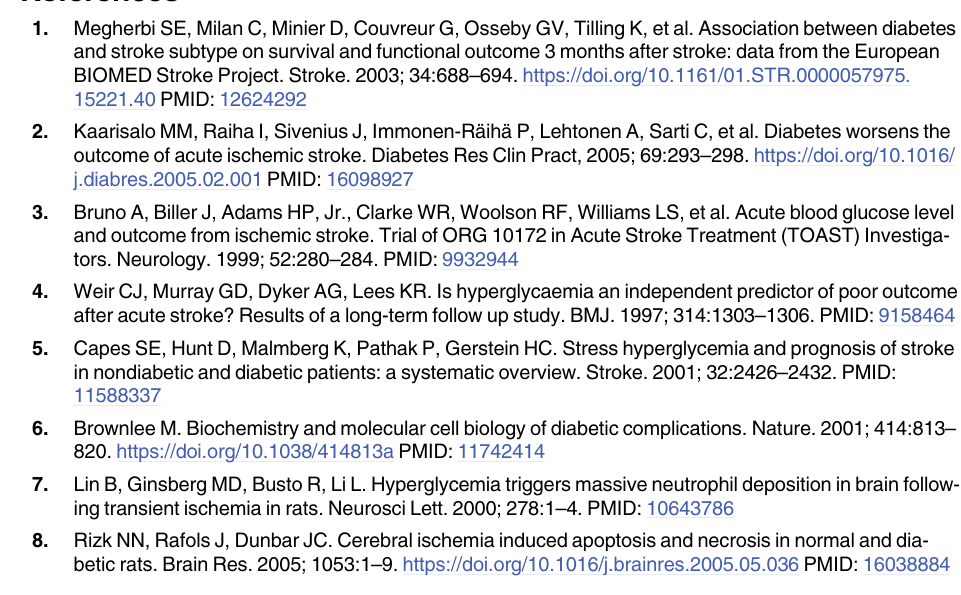
S1 Table. Multivariable ordinal logistic regression analyses of the predictors of unfavor- able shift in modified Rankin Scale score distribution at 3 month. OR, odds ratio; CI, confi- dence interval; TIA, transient ischemic attack; TOAST, Trial of Org 10172 in Acute Stroke Treatment; LAA, Large Artery Atherosclerosis; SVO, Small Vessel Occlusion; CE, Cardioem- bolism; SOE, Stroke of Other determined Etiology; SUE, Stroke of Undetermined Etiology; NIHSS, National Institutes of Health Stroke Scale; IV, Intravenous; A1c, glycated hemoglobin; Q1–4, quartile